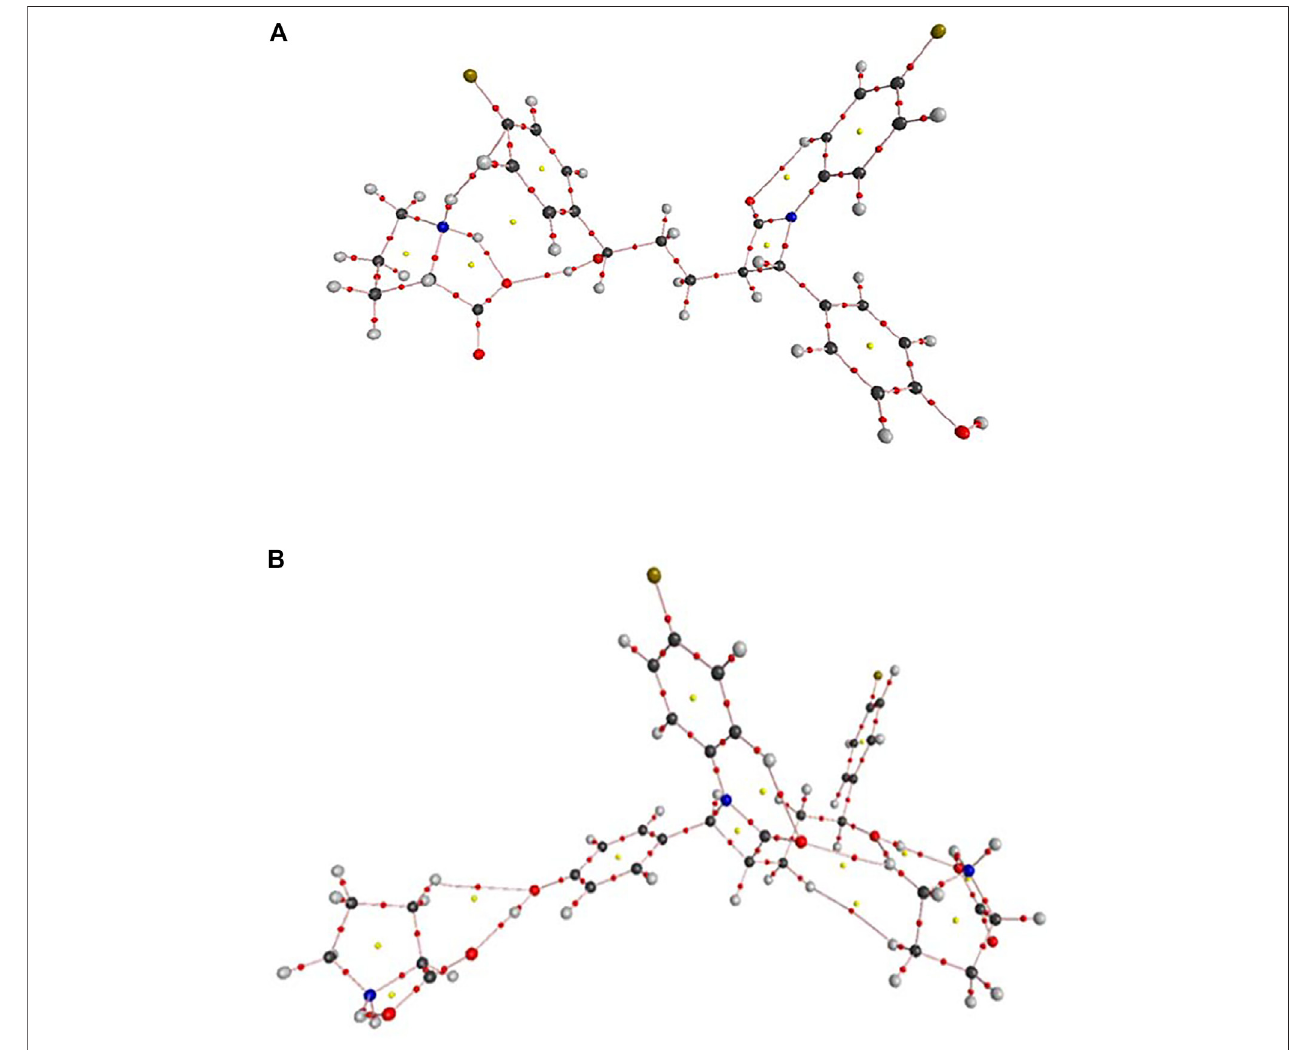
FIGURE 5 | (A) Molecular graph of the EZT + L-proline cocrystal. Bond critical points (small red spheres), ring critical points (small yellow sphere), and bond paths (pink lines) were calculated using B3LYP/6-311++G(d,p). (B) Molecular graph of the EZT + 2L-proline cocrystal. Bond critical points (small red spheres), ring critical points (small yellow sphere), and bond paths (pink lines) were calculated using B3LYP/6-311++G(d,p).